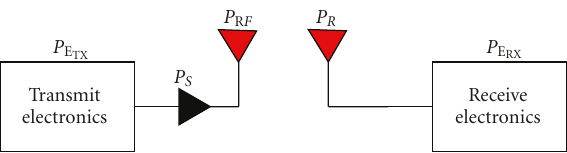
Figure 1: The high level block model of an RF